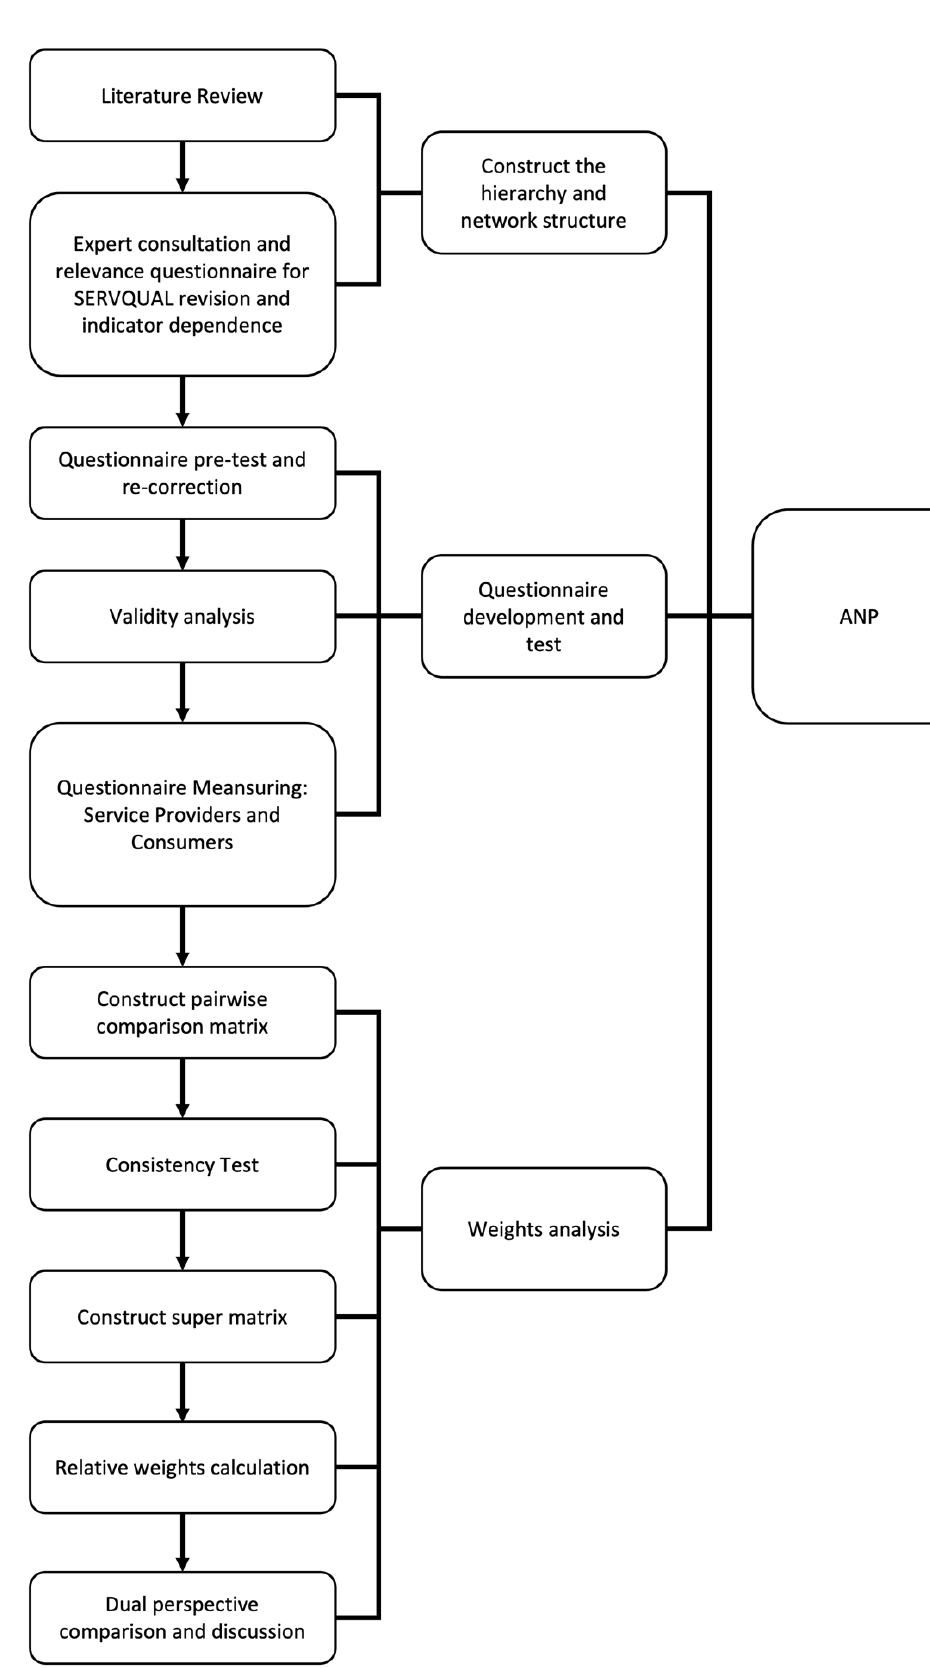
Figure 2. Research process of this research.